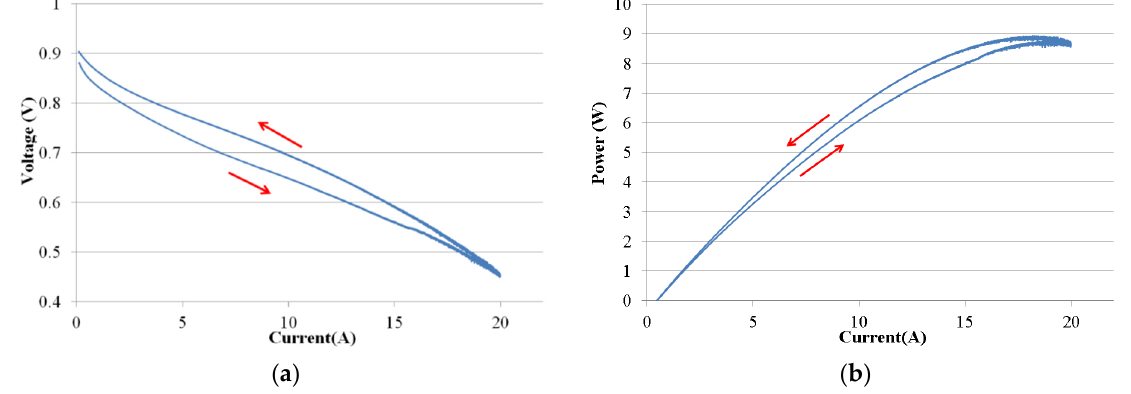
Figure 6. ( a ) Experimental V/I characteristic for the studied PEMFC. ( b ) PEMFC power vs. current.